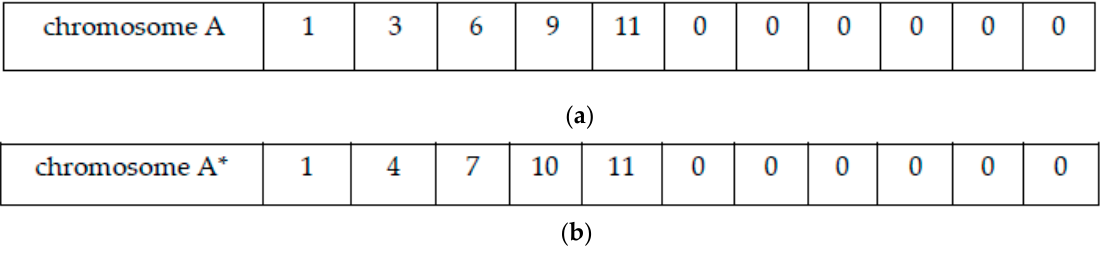
Figure 4. Operation diagram of chromosome crossover. ( a ) Chromosome A and B before crossing; ( b ) chromosomes A* and B* after crossing; and ( c ) chromosome A* and B* after complement and delocation.